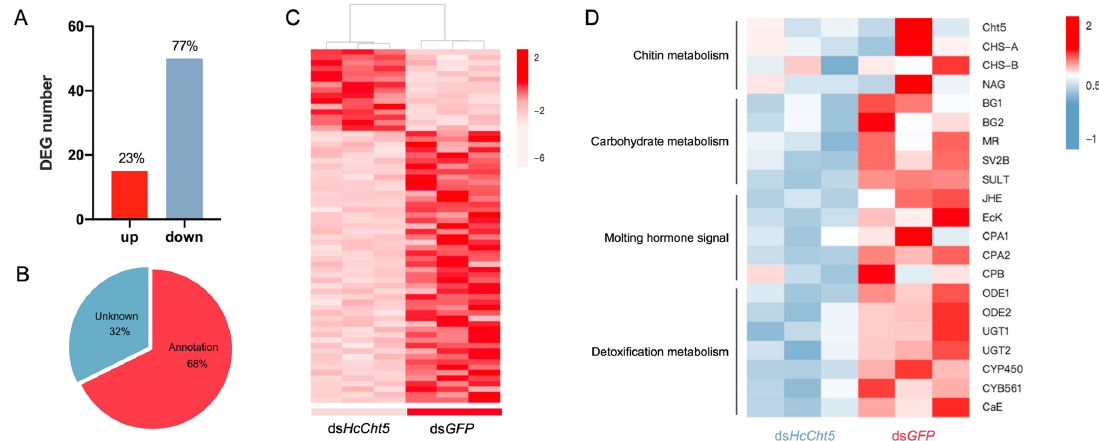
Figure 4. Differentially expressed gene (DEG) analysis of the ds HcCht5- and ds GFP -treated groups. ( A ) The number of DEGs in the ds HcCht5- treated group compared with the ds GFP group. Up indicates up regulated DEGs, and down indicates down-regulated DEGs. ( B ) The proportion of annotation and unknown DEGs. ( C ) Expression profiles of all DEGs between the ds HcCht5 and ds GFP groups. Each group contained three repeated samples. The color scale indicates the different expression levels, which were normalized as log 10 fragments per kilobase of transcript per million mapped reads (FPKM) values. ( D ) Expression profiles of some of the most down-regulated DEGs and other interesting DEGs in the ds HcCht5 and ds GFP groups. Each group contained three repeated samples. The color scale indicates the different expression levels. The letters on the right indicate putative gene names in H. cunea . Abbreviations: Cht5, chitinase 5; CHS-A and CHS-B, chitin synthase A and B; NAG, β - N -acetylglucosaminidase; BG1 and 2, β -glucosidase precursor 1 and 2; MR, putative mandelate racemase; SY2B, synaptic vesicle glycoprotein 2B-like; SULT, sulfotransferase; JHE, juvenile hormone esterase; EcK, ecdysteroid kinase; CPA and B, carboxypeptidase A and B; ODE1 and 2, odorant-degrading enzymes; UGT 1 and 2, UDP-glycosyltransferases; CYP450, cytochrome P450; CYB561, cytochrome b-561 domain containing protein; and CaE, carboxylesterase.